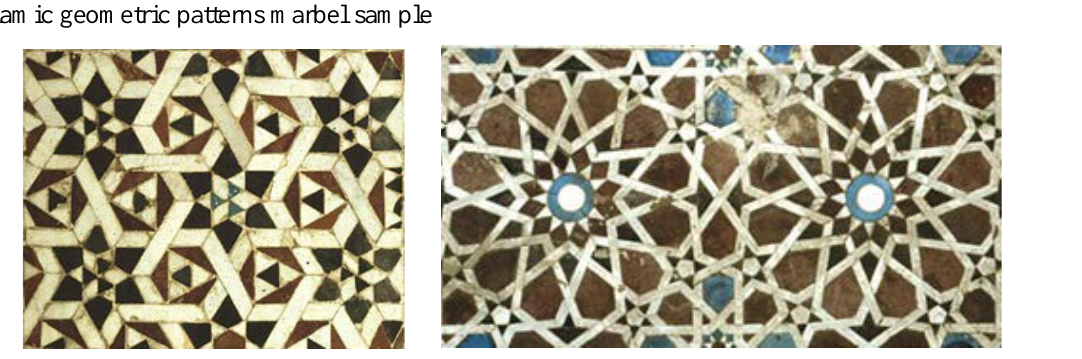
Figure 8-9 al-Maridani Mosque marbel work Figure8-10 al-Maridani Mosque marbel